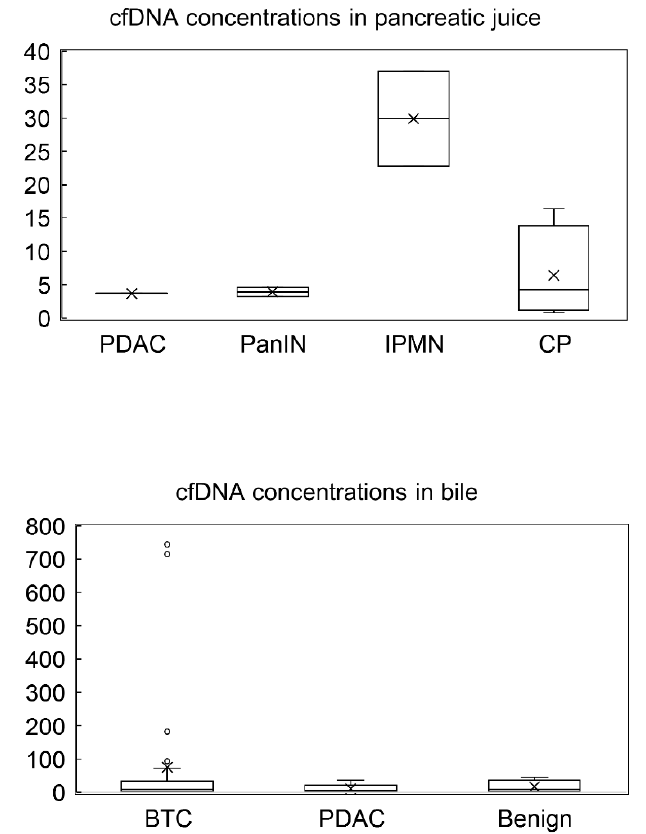
Figure 2. cfDNA concentrations in pancreatic juice and bile. cfDNA concentrations in pancreatic juice was higher in the IPMN group than in other groups (PDAC, PanIN and CP groups), while cfDNA concentrations in bile were similar in all the groups. PDAC, pancreatic ductal adenocarcinoma; PanIN, pancreatic intraepithelial lesion; IPMN, intraductal papillary mucinous neoplasm; CP, chronic pancreatitis; BTC, biliary tract cancer; Benign, benign stricture. x means the median and each circle means each value.